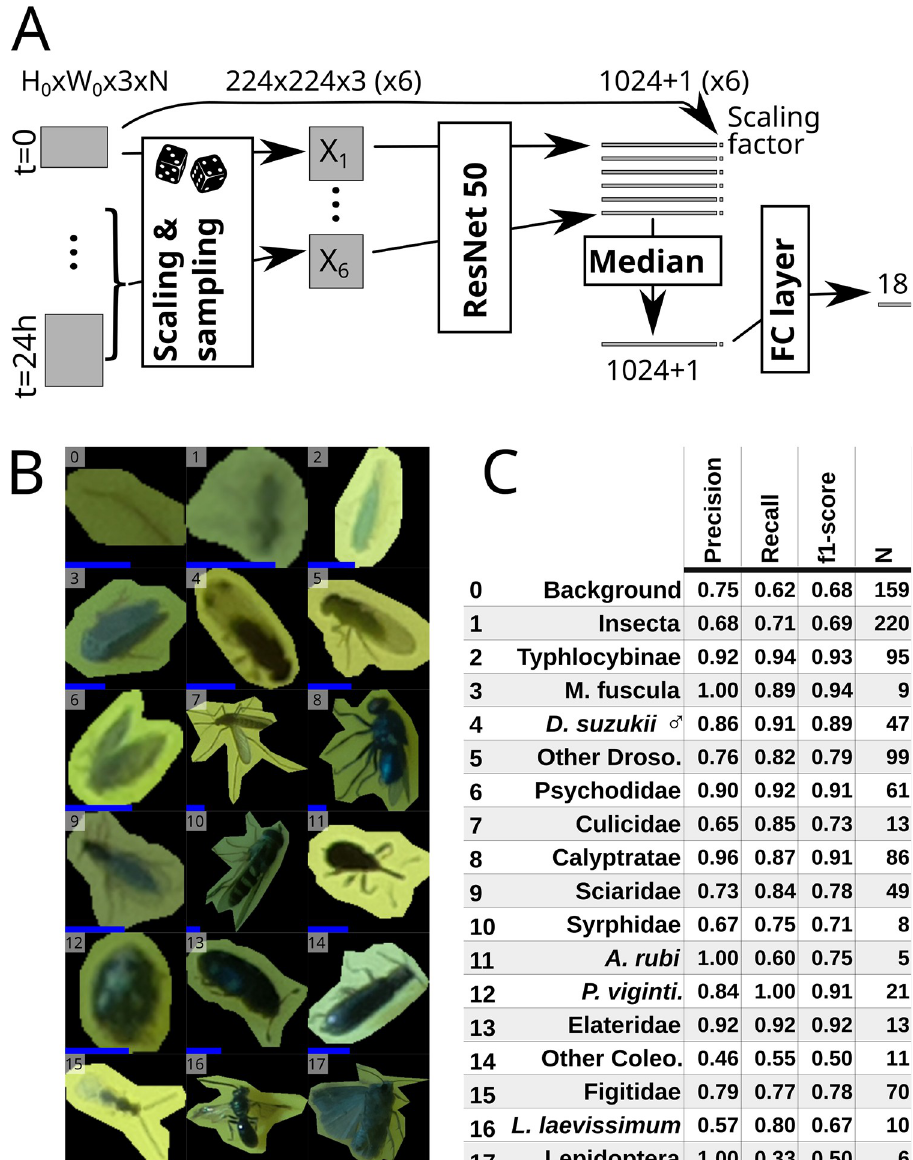
Fig 3. Insect Tuboid Classifier description and performance. (A) Algorithm to classify insect tuboids. The first image as well as 5 randomly selected within the first day of data are selected. Each image is scaled and processed by a ResNet50 network to generate an output feature vector per frame. Each vector is augmented with the original scale of the object, and the element-wise median over the 6 frames is computed. The resulting average feature vector is processed by a last, fully connected, layer with an output of 18 labels. (B) Representative examples of the 18 different classes. Note that we show only 1 image, but input tuboids have multiple frames. All images were rescaled and padded to 224 × 224 px squares: the input dimensions for the ResNet50. The added blue scale bar, on the bottom left of each tile, represents a length of 2 mm (i.e., 31 px). (C) Classification performance, showing precision, recall and f1-score (the harmonic mean of the precision and recall) for each label. Row numbers match labels in B. See S3 Table for the full confusion matrix. Abbreviated rows in C are Macropsis fuscula (3), Drosophila suzukii males (4), drosophilids that are not male D . suzukii (5), Anthonomus rubi (11), Psyllobora vigintimaculata (12), Coleoptera that do not belong to any above subgroup (14), and Lasioglossum laevissimum (16).